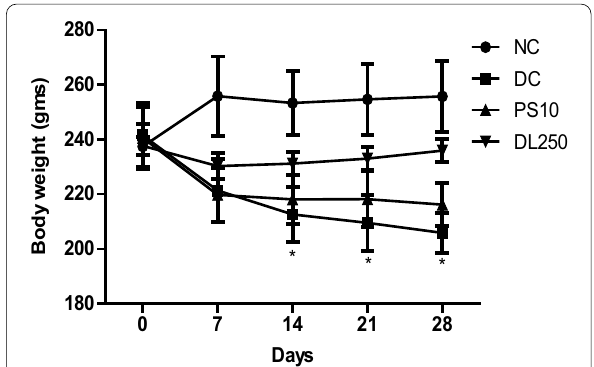
Data represented as mean SEM; * p < 0.05 compared to NC group and # p < 0.05 compared to DC group (one-way ANOVA followed by Tukey’s multiple comparison ± test). NC normal control group, DC CFA-induced arthritic group, PS10 prednisolone-treated group, DL250 dry latex of C. procera -treated group